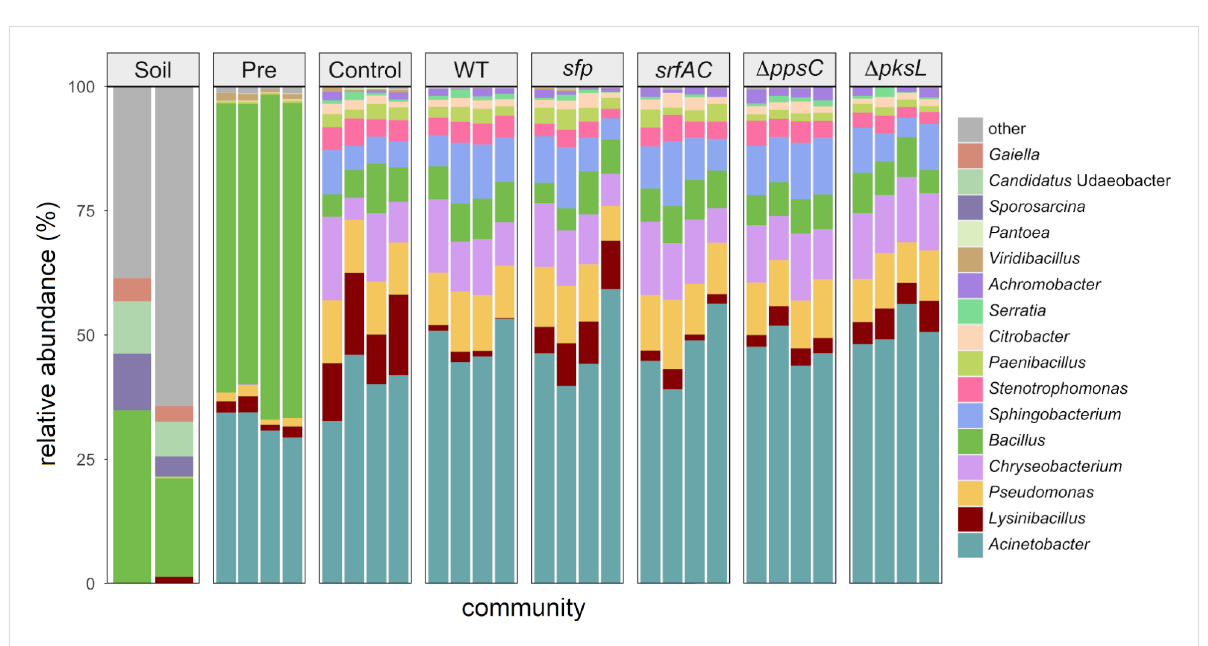
Figure 3: The taxonomic summaries are showing the relative abundance of the most abundant genera for each replicate of the soil sample (“soil”), 12 h preincubated soil suspensions (“Pre”), and untreated (“Control”) or treated mock communities with either B. subtilis wild type (“WT”), the NRP- deficient strain sfp , the surfactin mutant srfAC , the plipastatin mutant ∆ ppsC , or the bacillaene mutant ∆ pksL , cocultivated for 48 h. Genera are classi- fied as “other” when the relative abundance is <2% (“Soil”), <1% (“Pre”), or <0.19% (in all differently treated mock